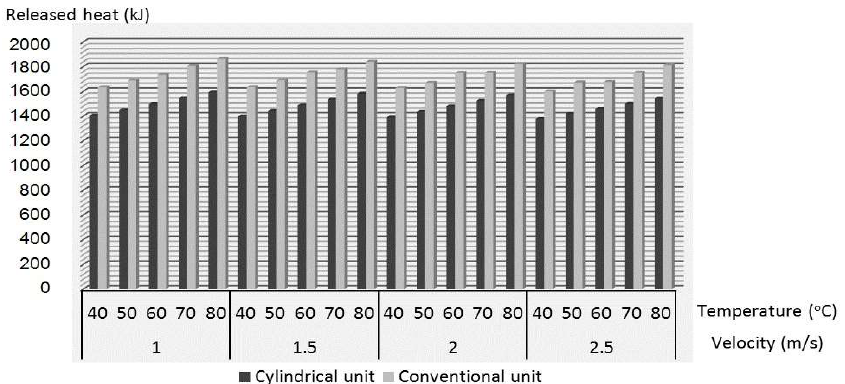
Figure 5. The amount of heat released in the atmosphere (average) (cylindrical unit—with deflector; conventional unit—without deflector).